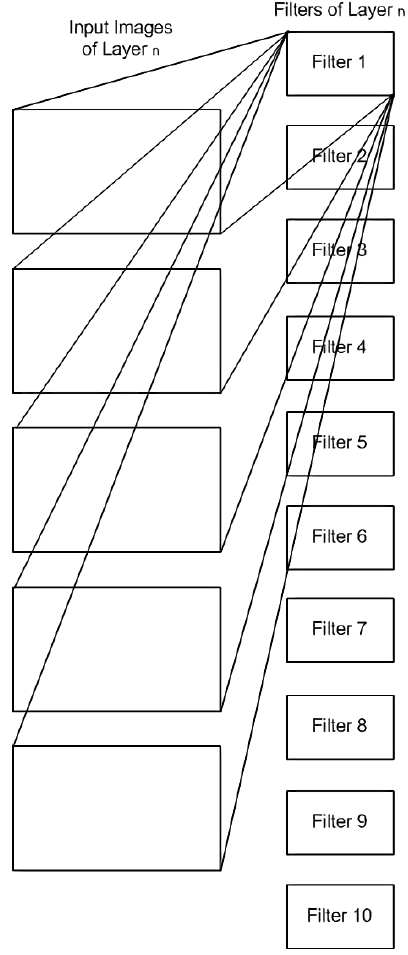
Figure 3. Layer n of a Convolutional neural